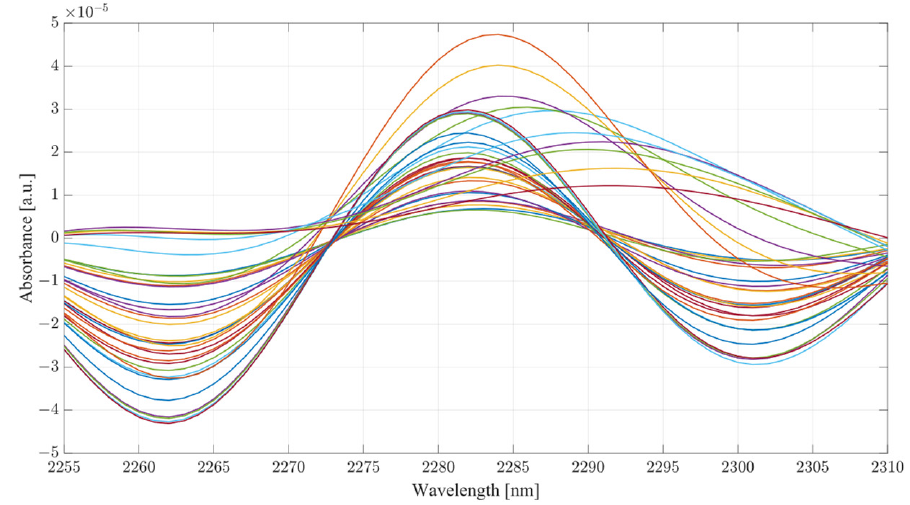
Figure 11. Peaks of 2262 and 2302 nm in serum mixtures.